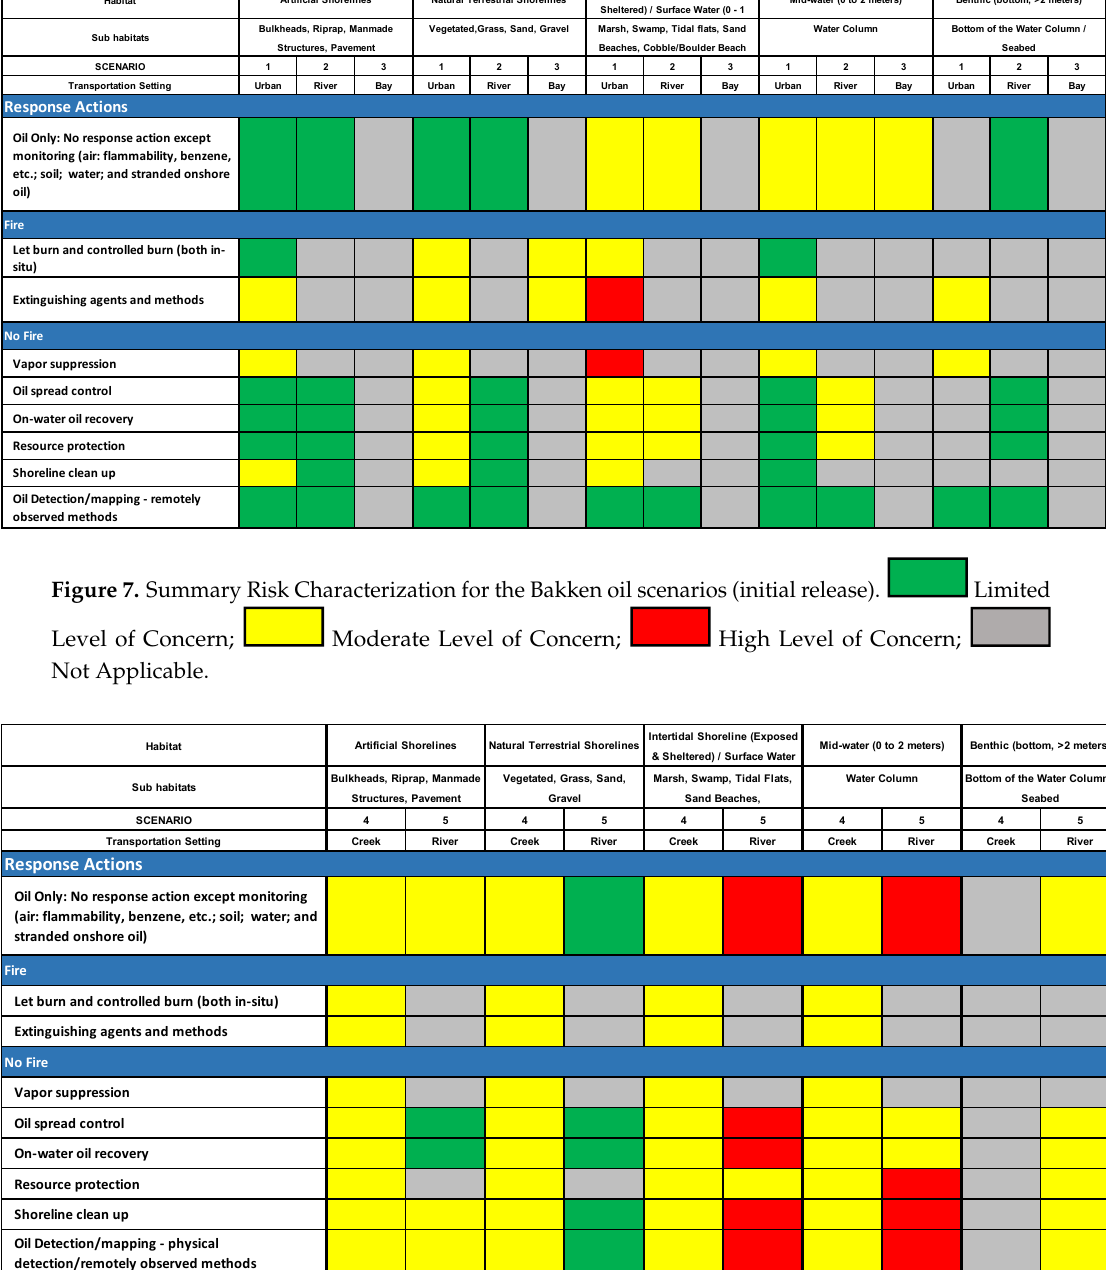
Figure 7. Summary Risk Characterization for the Bakken oil scenarios (initial release). Limited Level of Concern; Moderate Level of Concern; High Level of Concern; High Level of Concern; Not Applicable.